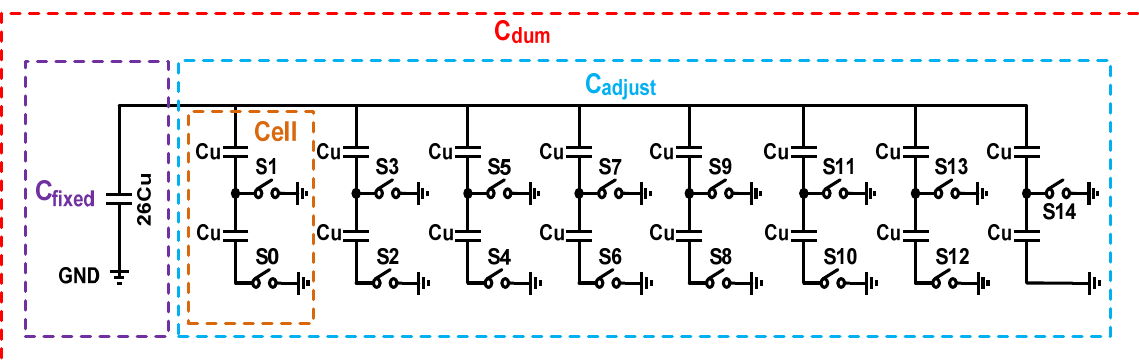
Figure 5. The programmable capacitor C dum .